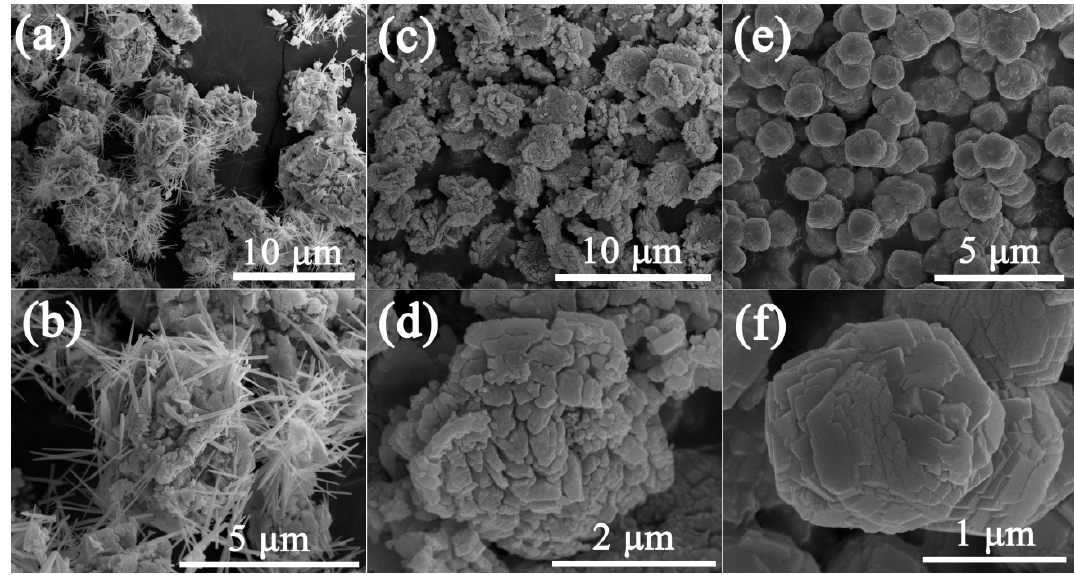
Figure 3. ZnO obtained with different amounts of TCD: 0 g ( a , b ), 0.03 g ( c , d ), or 0.12 g ( e , f ).